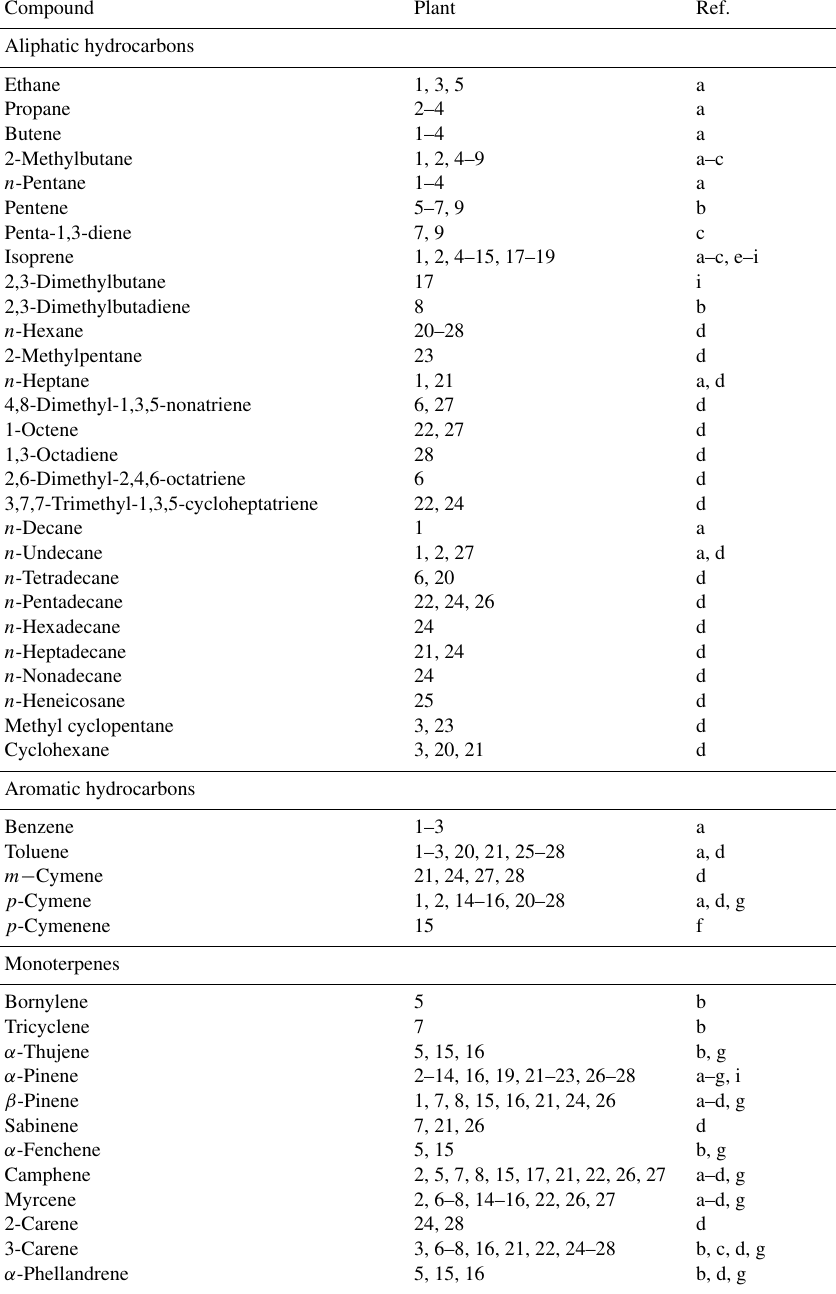
Table 3. VOC composition of some LSC plants (forests and bog forests). Plants: 1 – lichen ( Cetraria islandica ); 2 – heather ( Calluna vulgaris ); 3 – moss ( Pleurozium schreberi ); 4 – club moss ( Licopodium clavatum ); 5 – red bilberry ( Vaccinium vitis-idaea ); 6 – bilberry ( Vaccinium myrtillus ); 7 – moss ( Polytrichum commune ); 8 – marsh tea ( Ledum palustre ); 9 – male fern ( Dryopteris filix-mas ); 10 – soft tree fern ( Dicksonia antarctica ); 11 – Japanese beech fern ( Thelypteris decursive-pinnata ); 12 – southern shield fern ( Thelypteris kunthii ); 13 – cottongrass ( Eriophorum sp.); 14 – red raspberry ( Rubus idaeus ); 15 – Labrador tea ( Rhododendron groenlandicum ); 16 - bog heather ( Erica tetralix ); 17 – sphagnum ( Sphagnum fuscum ); 18 – thick stemmed wood fern ( Dryopteris crassirhizoma ); 19 – marsh andromeda ( Andromeda polifolia ); 20 – lichen ( Cladonia arbuscular ); 21 – moss ( Dicranum polysetum ); 22 – moss ( Hylocomium splendens ); 23 – moss ( Leucobryum glaucum ); 24 – moss ( Sphagnum fallax ); 25 – pipsissewa ( Chimaphilla umbellata ); 26 – European clefthoof ( Asarum europaeum ); 27 – catsfoot ( Antennaria dioica ); 28 – fern ( Pteridium aquilinum ). References: a – Isidorov et al. (1994); b – Isidorov (1992); c – Isidorov et al. (1985); d – Isisorov et al. (2022); e – Tingey et al. (1987); f – Drewitt et al. (1998); g – Helmig et al. (1999); h – Mochizuki et al. (2014); i – Rinnan et al.